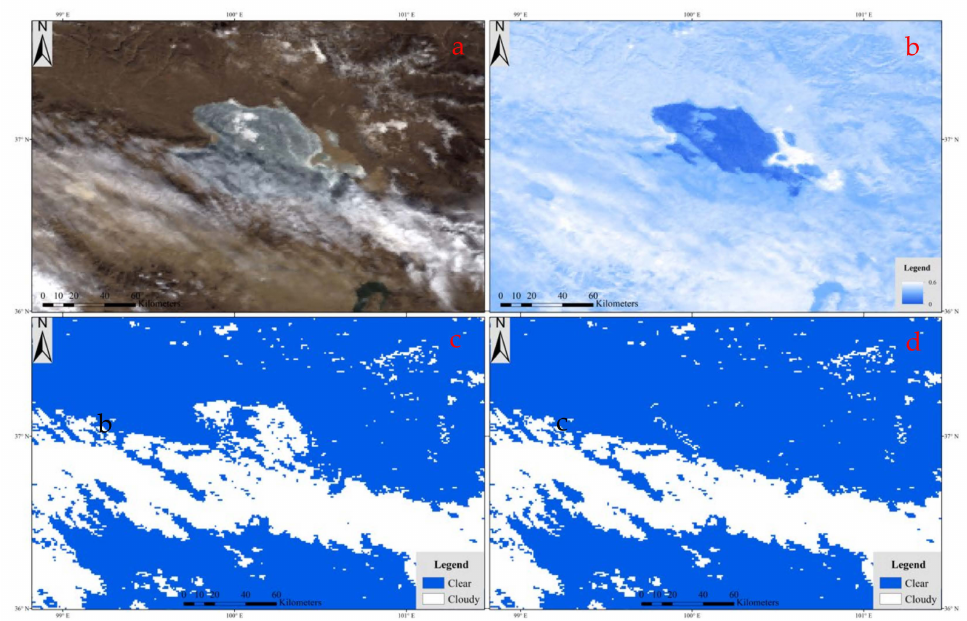
Figure 14. Correction effect of the SWIR threshold method. ( a ) True-color image of Qinghai Lake (Band 1, 4, 3) on 6 January 2001; ( b ) short-wave infrared image (Band 7); ( c ) uncorrected MOD09 cloud mask; ( d ) corrected MOD09 cloud